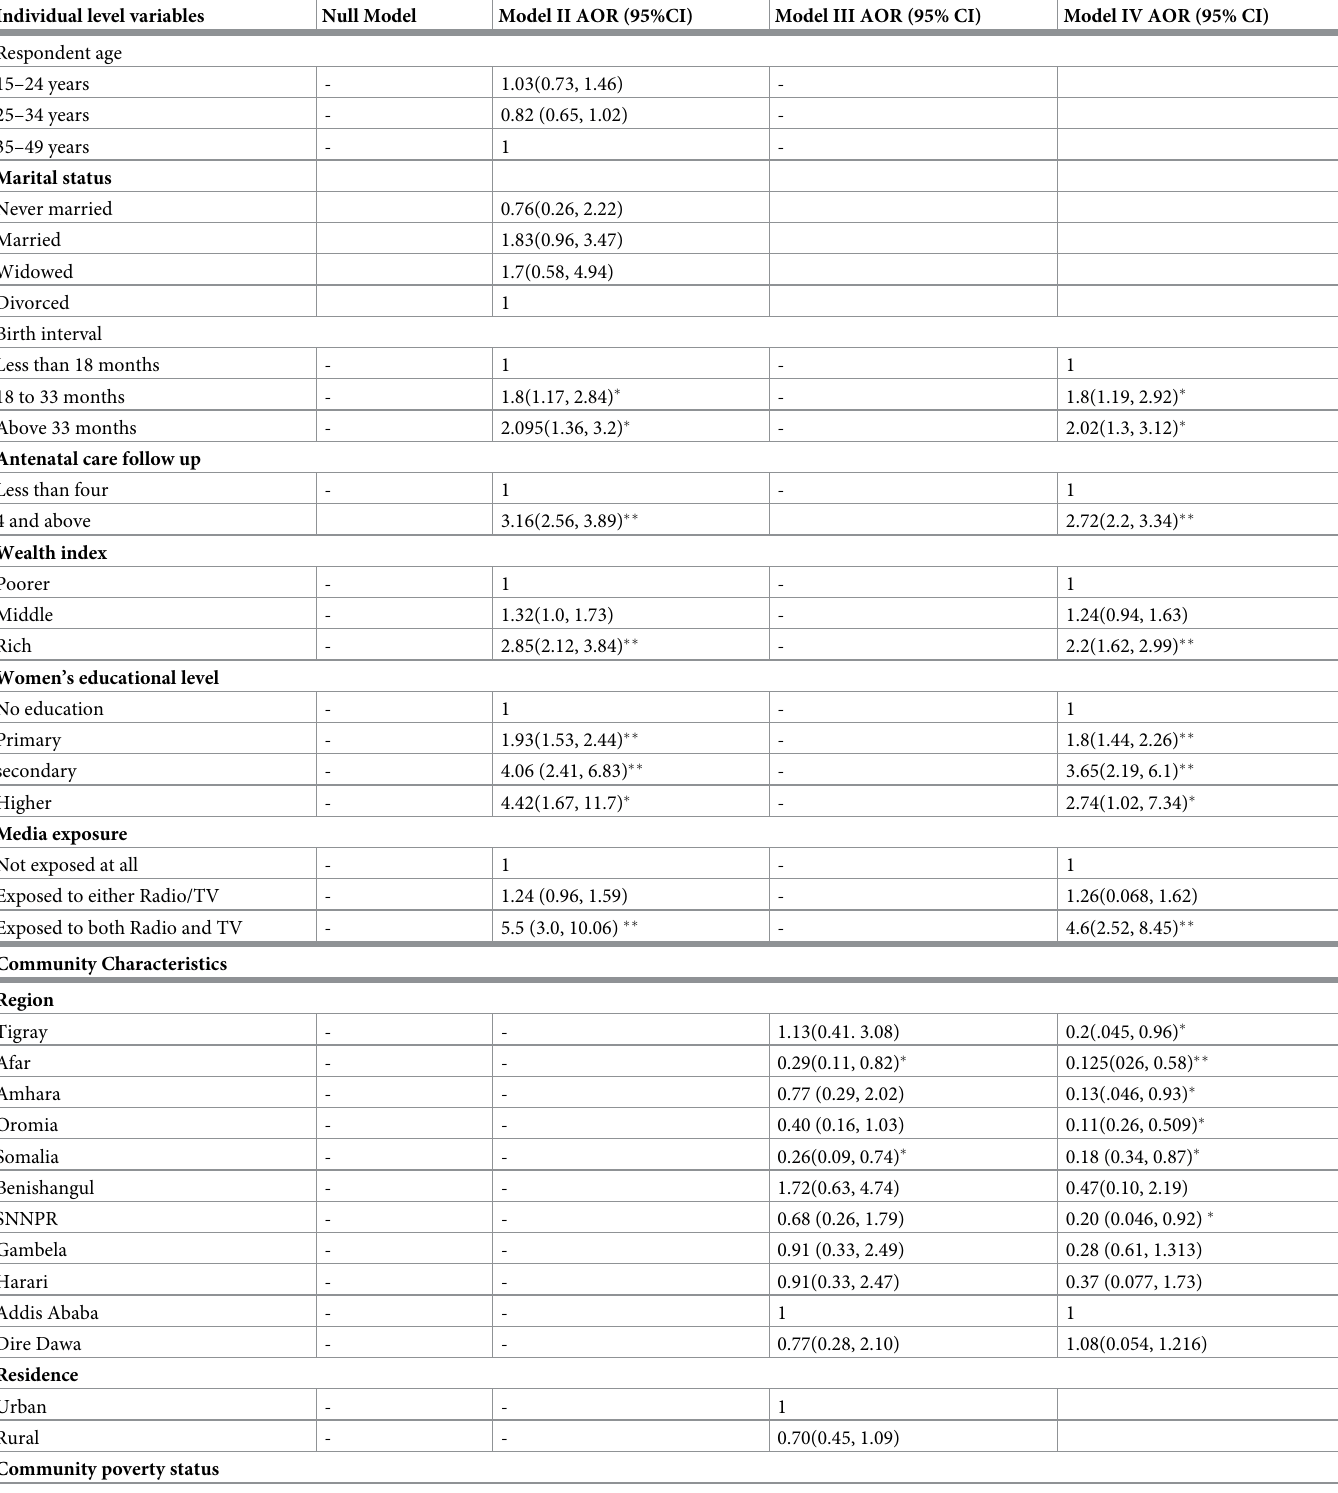
Table 3. Multilevel binary logistic regression analysis of individual and community-level factors among women who had live births within five years preceding (EDHS) 2019,